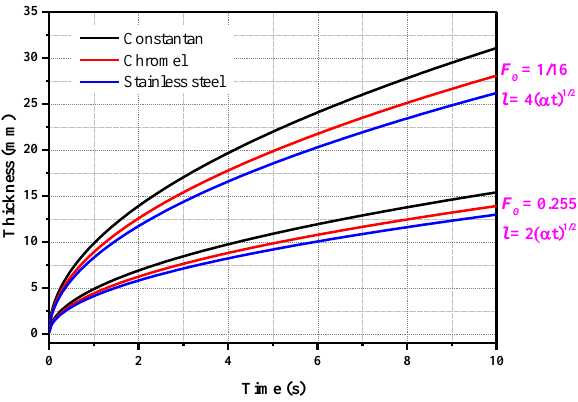
Figure 3. Thickness of the plate versus time for different Fourier numbers.